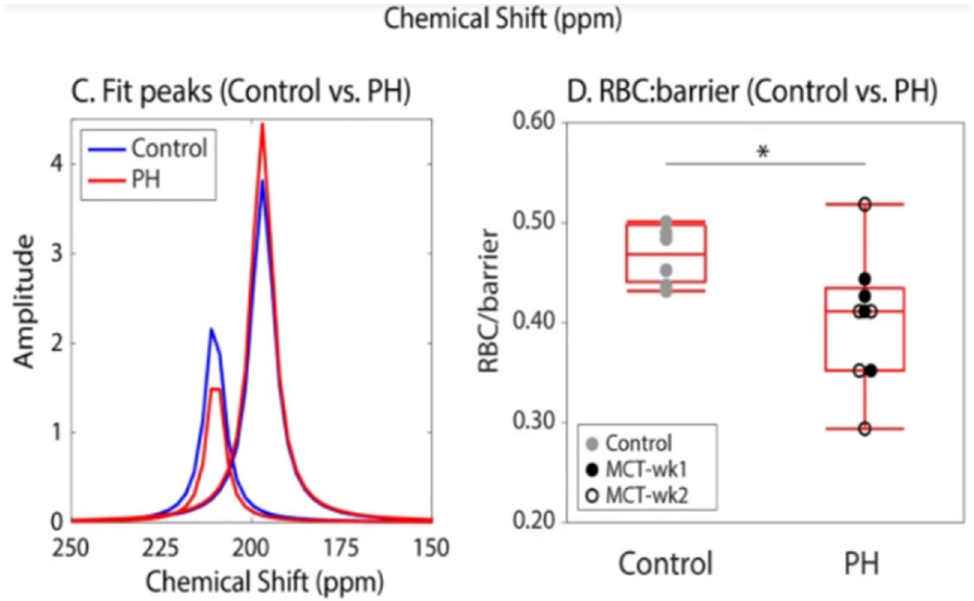
Figure 16. Instillation of a monocrotaline model in experimental rats reduces the observed ratio of RBC to barrier signals after one and two weeks. * = p < 0.05. Reprinted with permission from Virgincar, et al. ( Sci Rep 2020, ref.